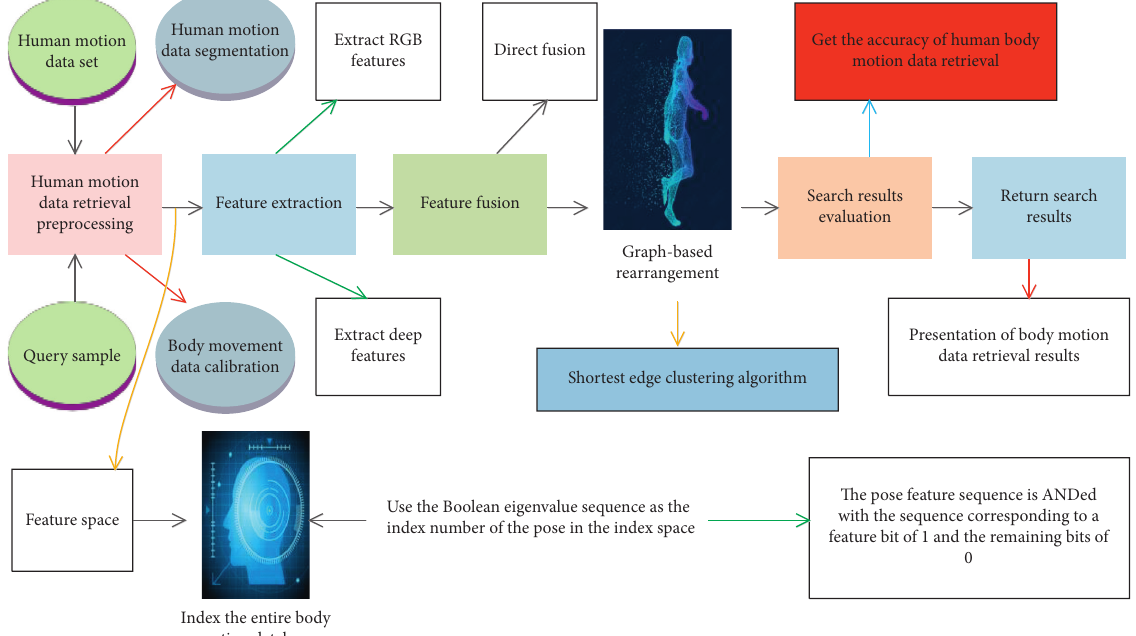
Figure 2: Video retrieval framework based on human